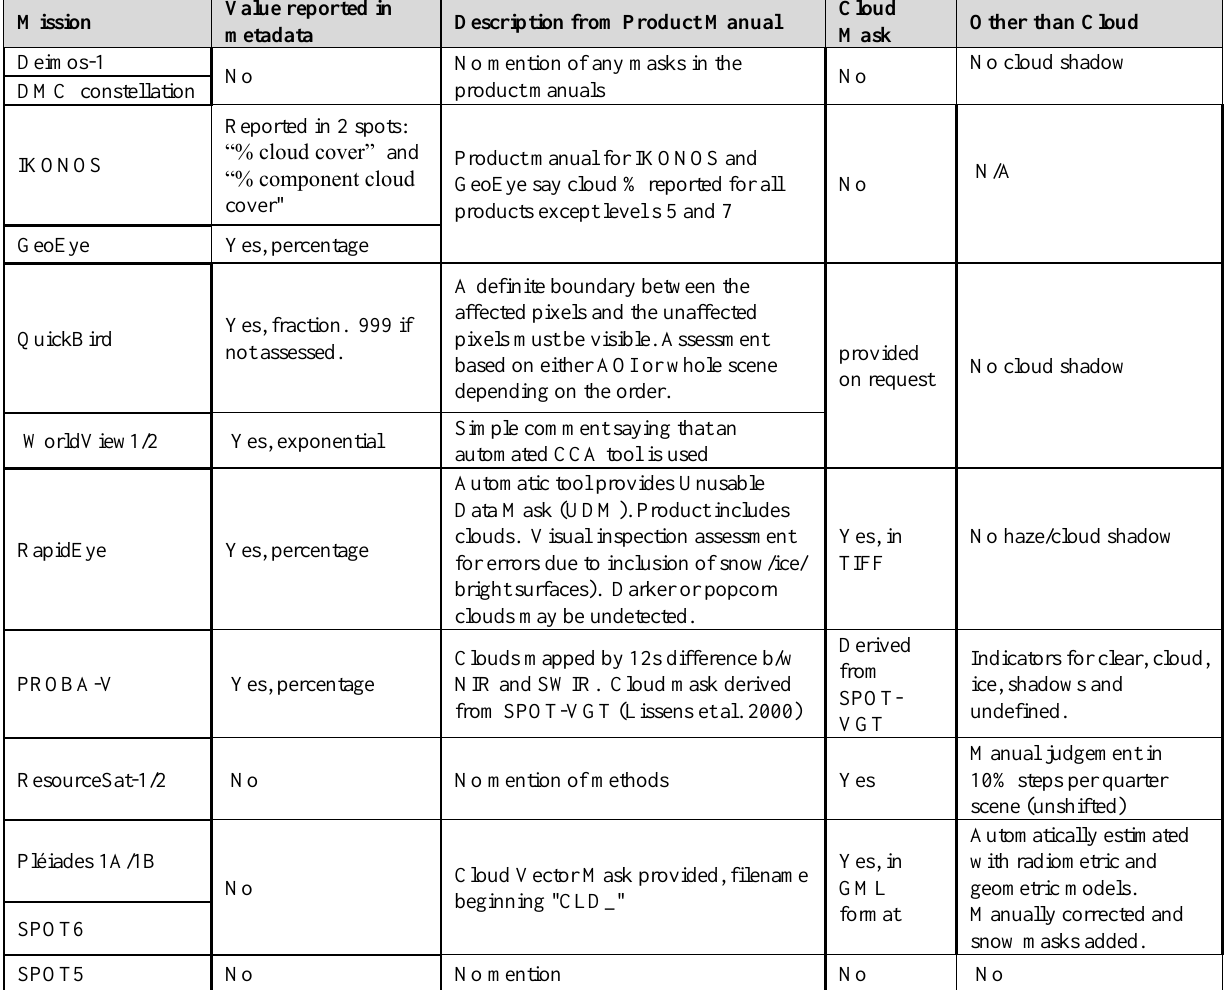
Table 2. Cloud information reported in different sources (metadata, users’ manual,